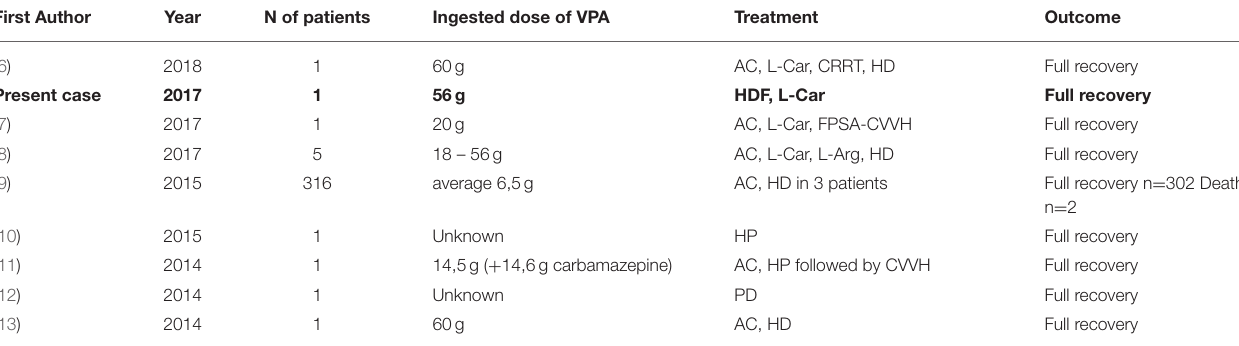
TABLE 1 | Overview of published cases of VPA intoxication treated with extracorporeal removal